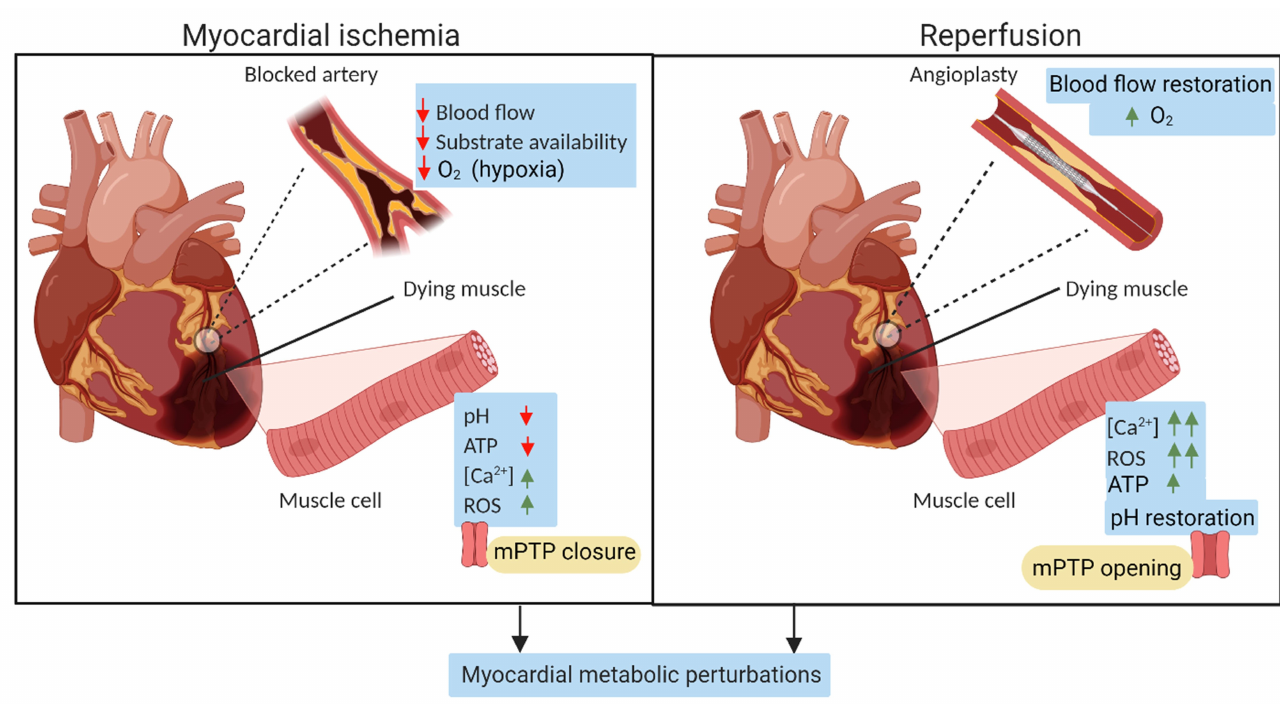
Figure 5. Myocardial ischemia/reperfusion (I/R) injury. Schematic showing the main events in myocardial I/R injury. Abbreviations: Ca 2+ , Calcium ion; ROS, reactive oxygen species; mPTP, mitochondrial permeability transition